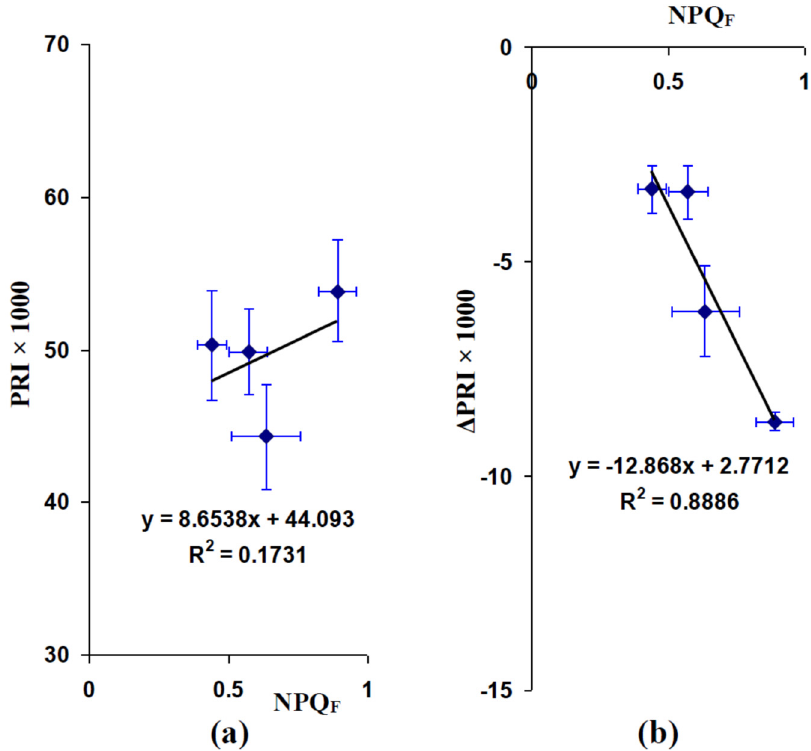
Figure 9. Scatter plots between NPQ F and PRI ( a ) and between NPQ F and ∆ PRI ( b ) in experiments with heating. K H = 7.5327 and K ∆ H = − 12.868 are linear regression coefficients in the plots ( a ) and ( b ), respectively. Average values of parameters and standard errors from Figure 8 were used. R 2 is the determination coefficient. Bars show standard errors.